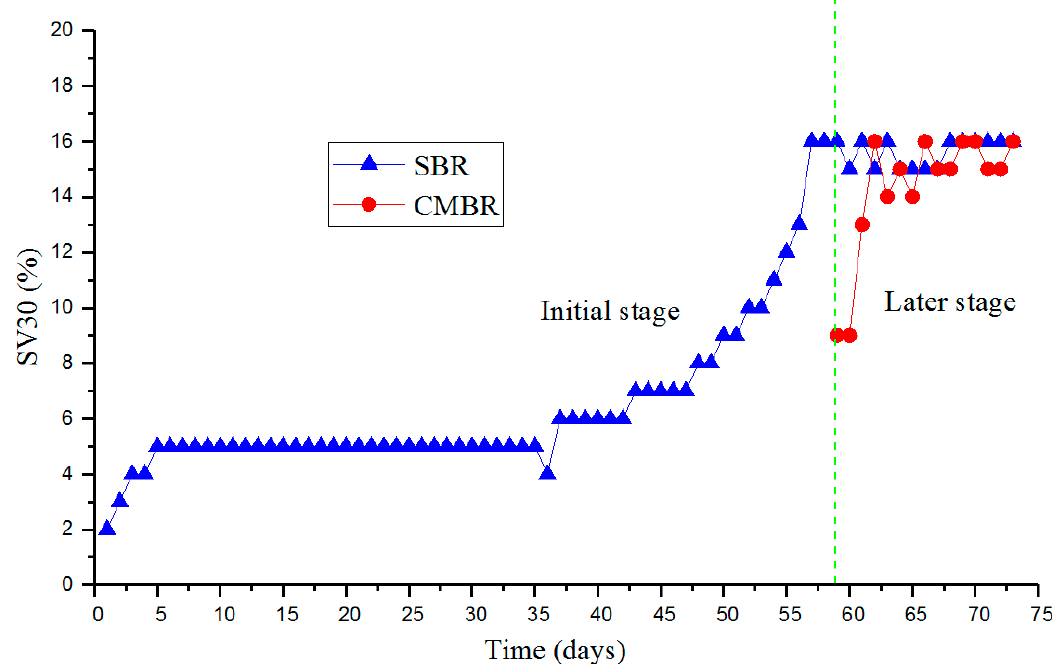
Int. J. Environ. Res. Public Health 2020 , 17 , x FOR PEER REVIEW Figure 2. The sludge settling ratio (SV30) change during the debugging period. Figure 2. The sludge settling ratio (SV30) change during the debugging period.